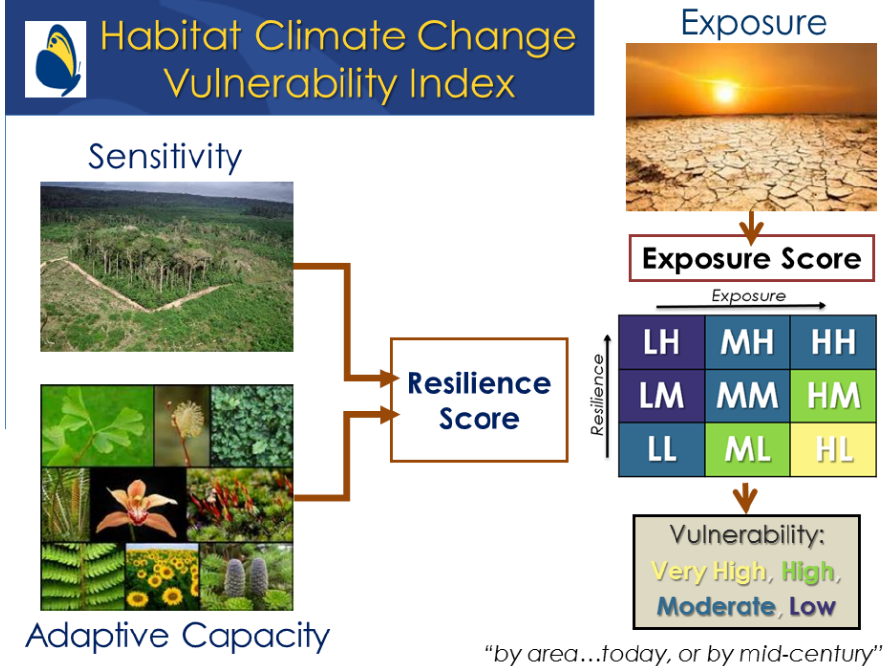
Figure 2. Analytical framework for the NatureServe Habitat Climate Change Vulnerability Index (from [10]).